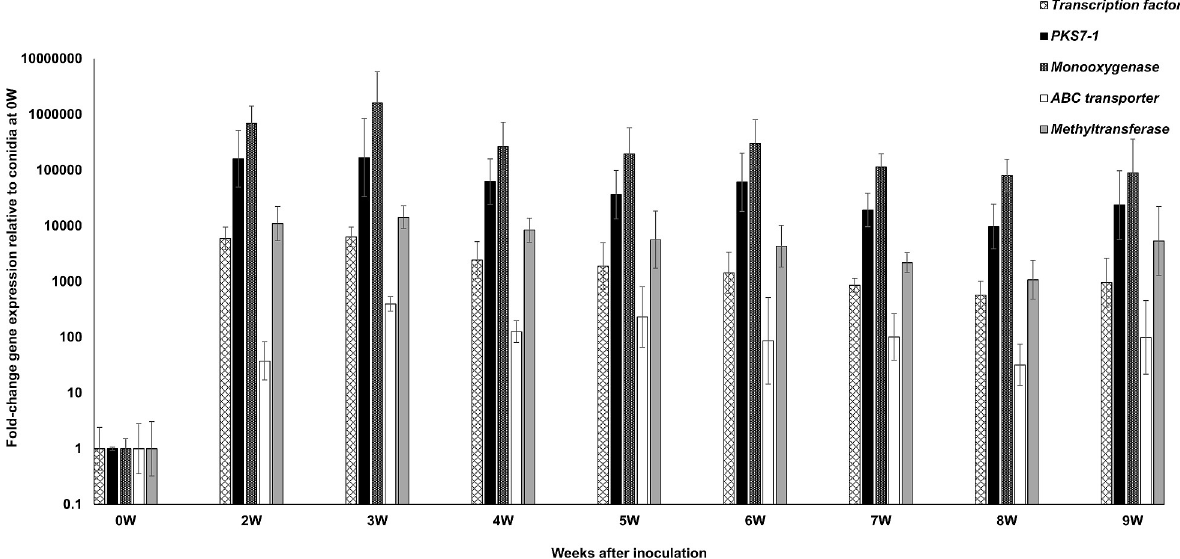
Fig 1. Time course of fold-change gene expression of PKS7-1 cluster genes in wild type P . fijiensis isolate 10CR1-24 in infected banana relative to expression in conidia used for inoculation. PKS7-1 cluster genes assessed include the Zn(II)2 CYS6 transcription factor, PKS7-1 , the monooxygenase/hydrolase, the O-methyltransferase, and the ABC transporter genes. To determine gene expression, tissue was harvested from infected banana plants at weekly intervals starting at 2 weeks through 9 weeks post-inoculation. Fold-change gene expression is shown relative to the expression at 0 weeks (in conidia) which is set to 1, with error bars indicating standard error from three biological replicates. W = week.